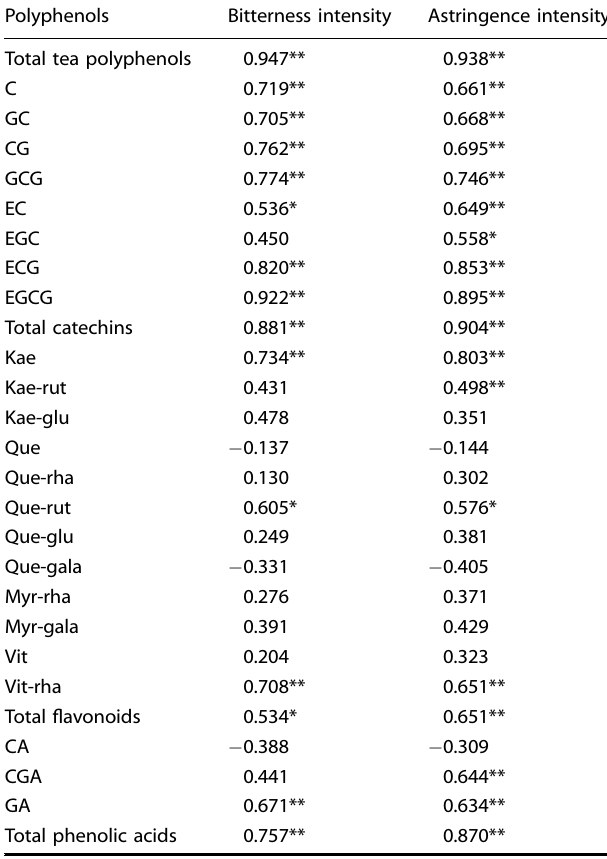
Table 1. Correlation coef fi cients between the intensity of bitterness and astringency, and polyphenols in green tea infusion.